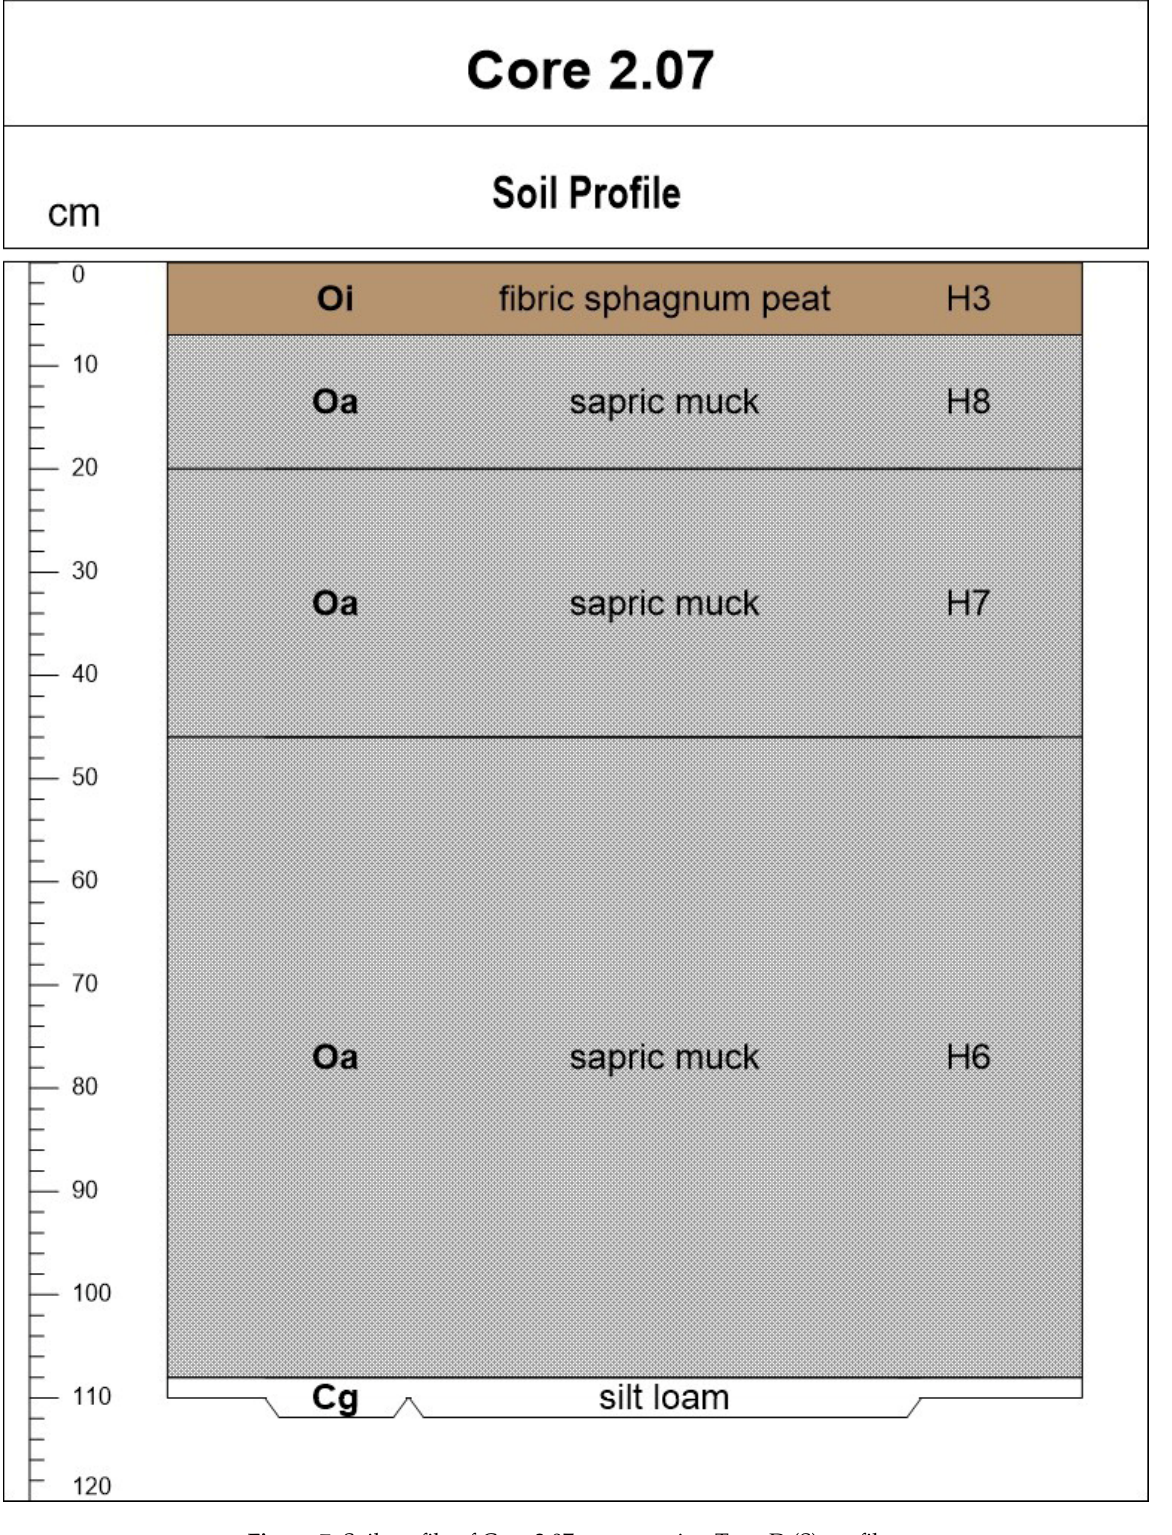
Figure 7. Soil profile of Core 2.07, representing Type D (S) profiles. Type E soil profiles had a catotelm sequence of a hemic horizon underlain by a sapric horizon (HS) (Figure 8). This horizonation occurred in four of the five peatlands (Table 2 and Figure 2). Type E (HS) soil profiles typically occurred surrounding clusters of Type C (HSH) soil profiles. Type E (HS) profiles were generally shallower than Type C